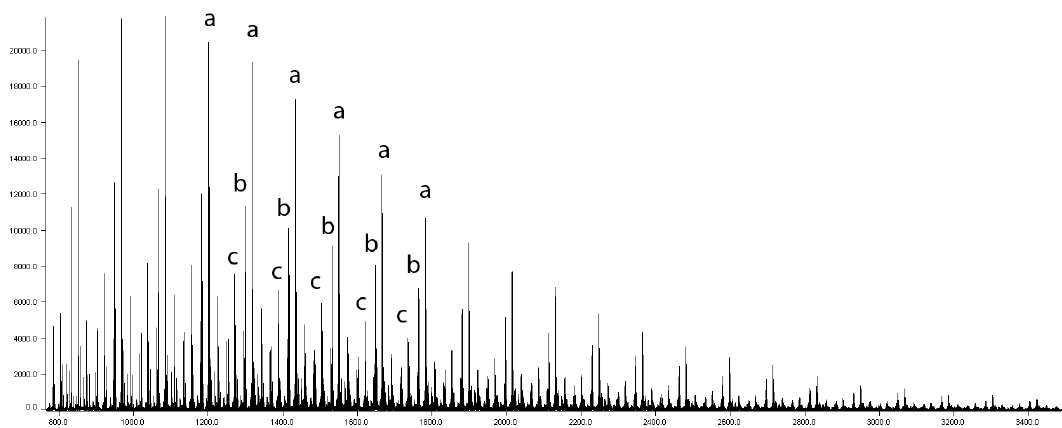
Figure 6. MALDI-TOF (DCTB, Na+) spectrum of POX with 1,1,1-tris(hydroxymethyl)propane (TMP) core; a-a distance ∆ m / z = 116.